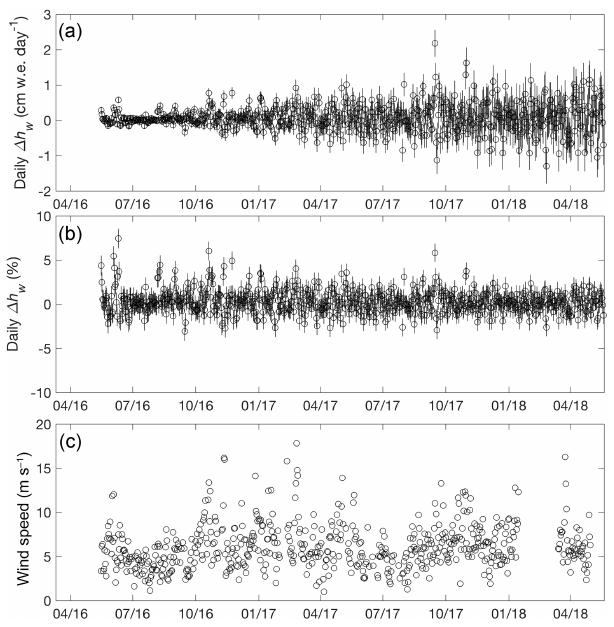
Figure 5. (a) Daily change in water-equivalent (w.e.) thickness, h w , and (b) change as a percentage of h w at Summit Station, Green- land, measured by the cosmic ray neutron sensor (CRNS) with 1 σ error bars estimated from the daily SDs in hourly measurements ver- sus water-equivalent thickness (curve in Fig. 4.). (c) Summit Camp daily mean wind speed measured at the automatic weather station.